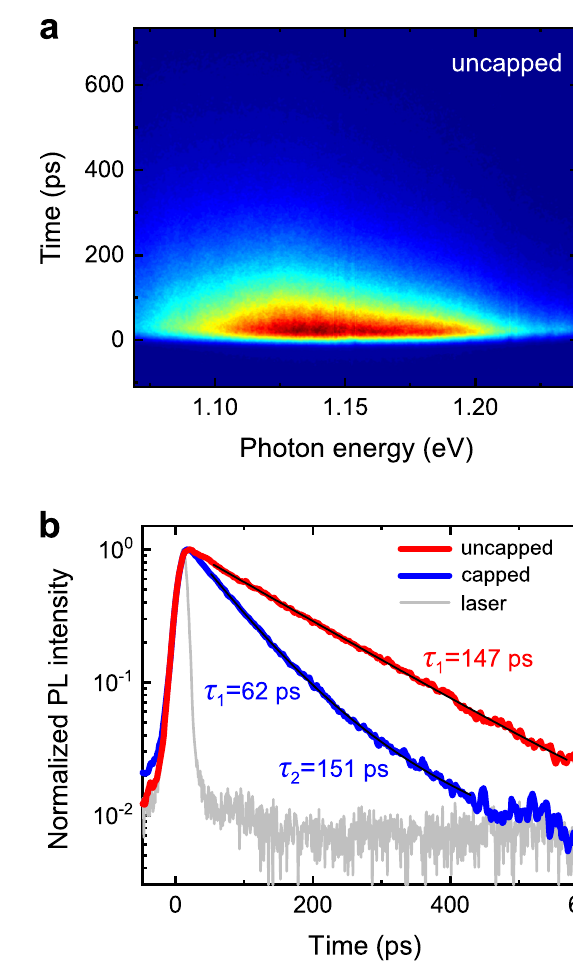
Fig. 5 Study of charge carrier dynamics in the core of GaAs/ In 0.37 Al 0.63 As (uncapped) and GaAs/In 0.43 Al 0.57 As/In 0.44 Ga 0.56 As (capped) core/shell nanowires at room temperature. a Time-resolved photoluminescence spectroscopy scan from uncapped nanowires. b Integrated photoluminescence intensity (normalised) as a function of time for uncapped (red curve) and capped (blue curve) nanowires. The data have been fi tted with mono-exponential (uncapped nanowires) and bi- exponential (capped nanowires) decay functions (black curves), and the resulting lifetimes are